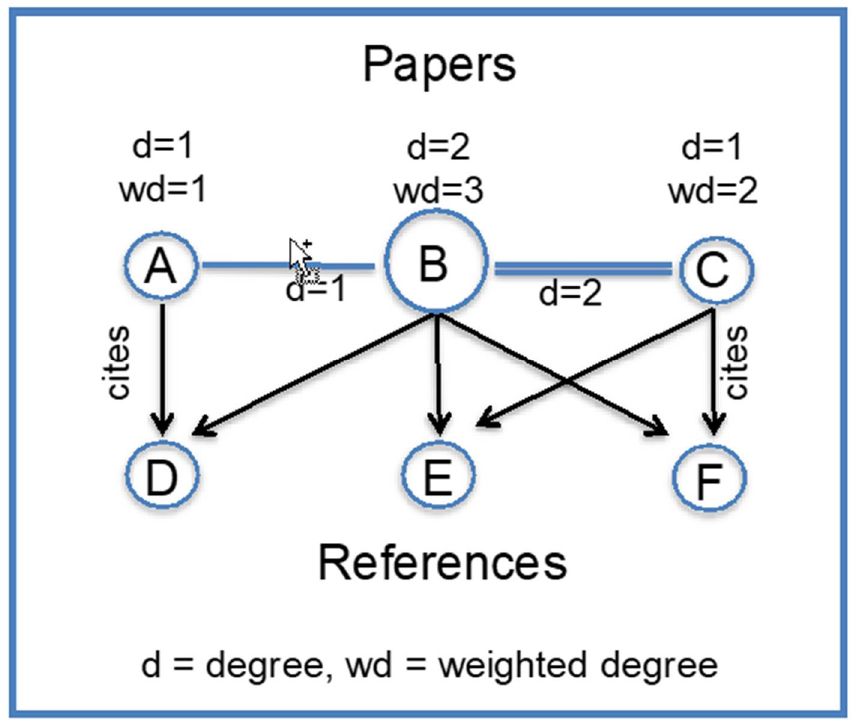
Figure 1. Bibliographic coupling and the degree of nodes and edges (based on Friege and Chappin [23] (p. 198)). Papers A and B both cite the same document D, so that A and B are connected by a line with a weight of d = 1. In contrast, B and C both cite the same documents E and F, so the edge between B and C is a double-weighted line (d = 2). Node A has a degree of d = 1 and wd = 1, while B has a degree of d = 2 and a wd =